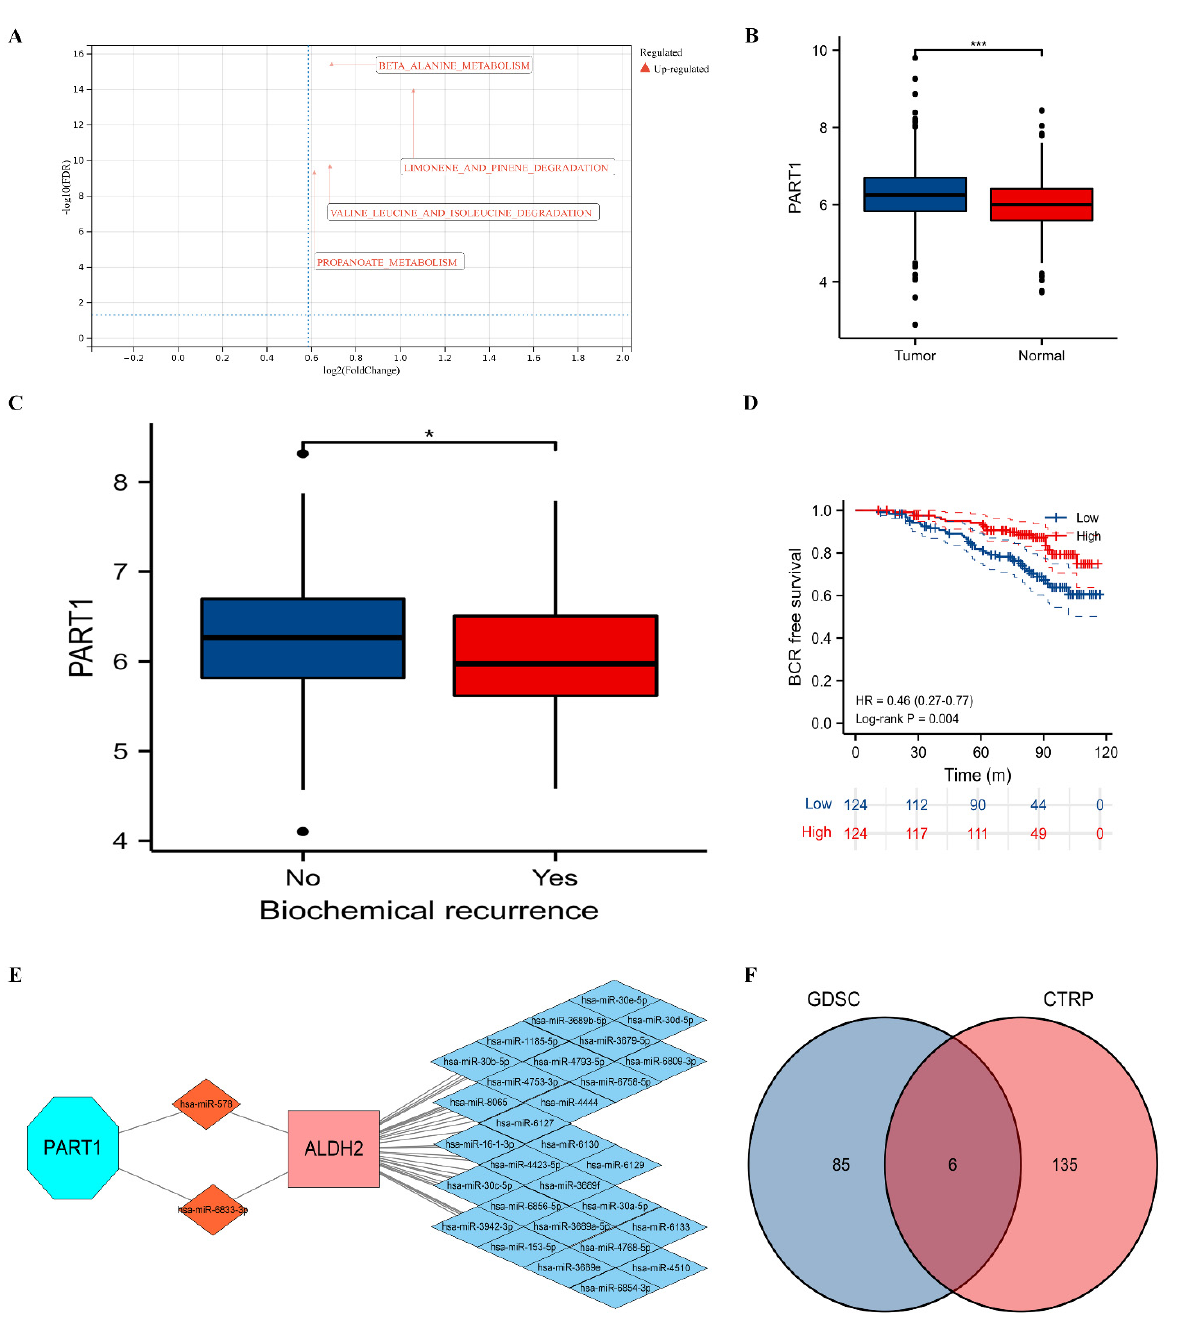
Figure 3. Functional enrichment analysis, ceRNA network, and drug analysis. ( A ) Gene set enrichment analysis; ( B ) comparison between tumor and normal groups for PART1; ( C ) comparison between BCR and no BCR groups for PART1; ( D ) Kaplan–Meier curve of PART1 for BCR-free survival; ( E ) ceRNA network; and ( F ) Venn plot showing the commonly sensitive drugs to ALDH2. ceRNA = competing endogenous RNA; BCR = biochemical recurrence. ns, 0.05; *, 0.05; and ***, 0.001.